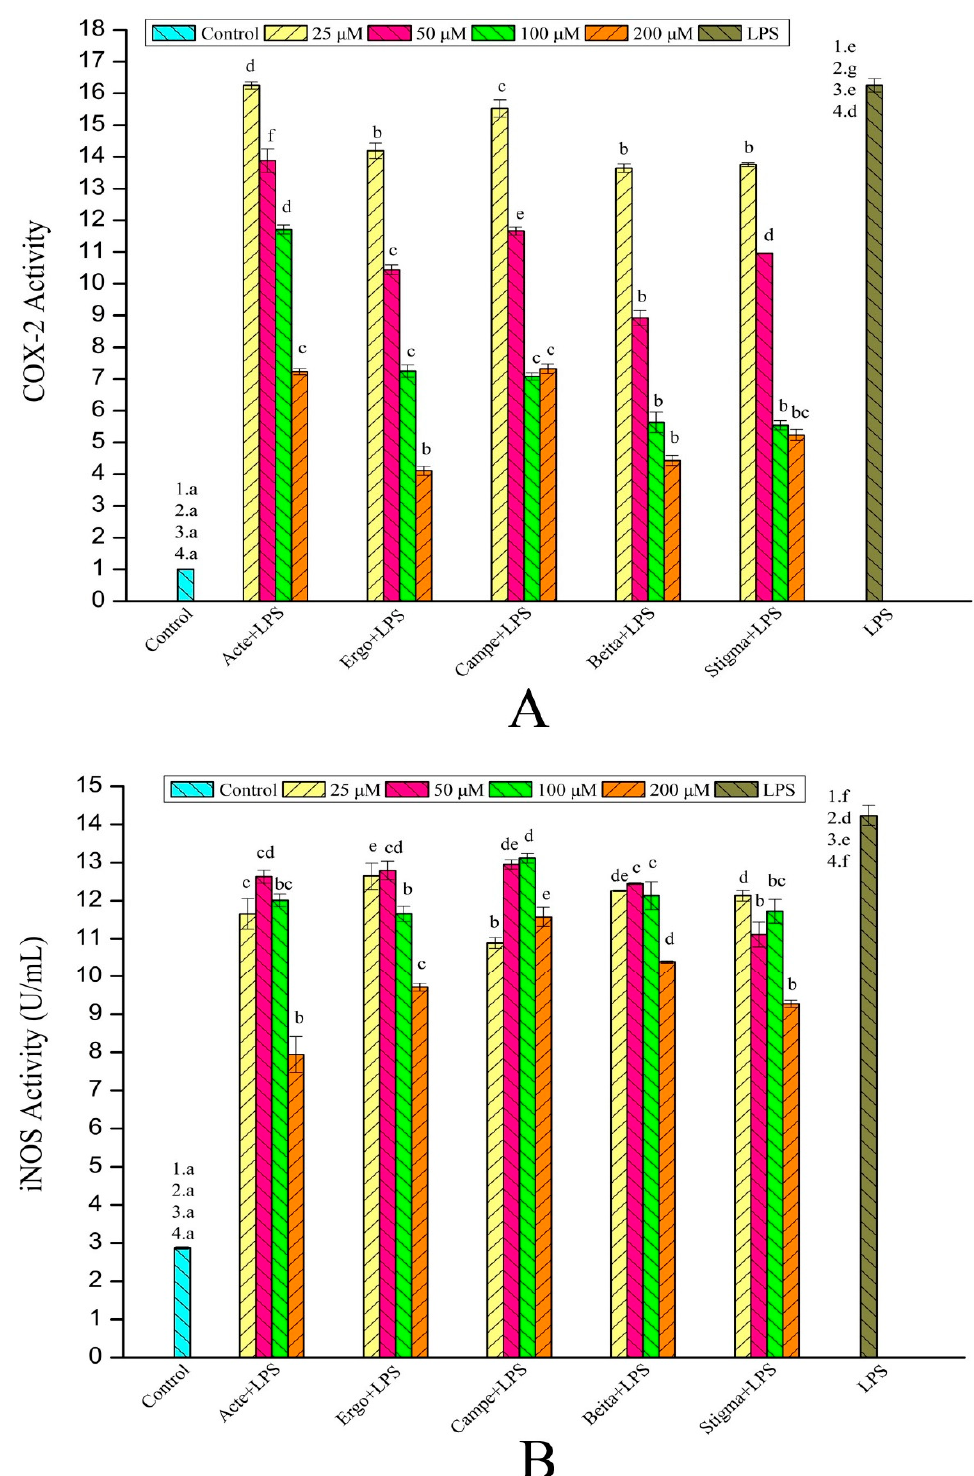
Figure 7. Effects of phytosterols on the activities of inflammatory regulators: ( A ) COX-2, ( B ) iNOS. Acte (ergosterol acetate); Ergo (ergosterol); Campe (campesterol); Beita ( β -sitosterol); Stigma (stigmasterol). The data are expressed as means ± SEM; different superscript letters for columns at the same concentration denote a significant difference ( p < 0.05); the numbers describe that the control/model group was compared with the experimental group at the concentrations of 25 (1), 50 (2., 100 (3), and 200 (4) μ M, respectively.